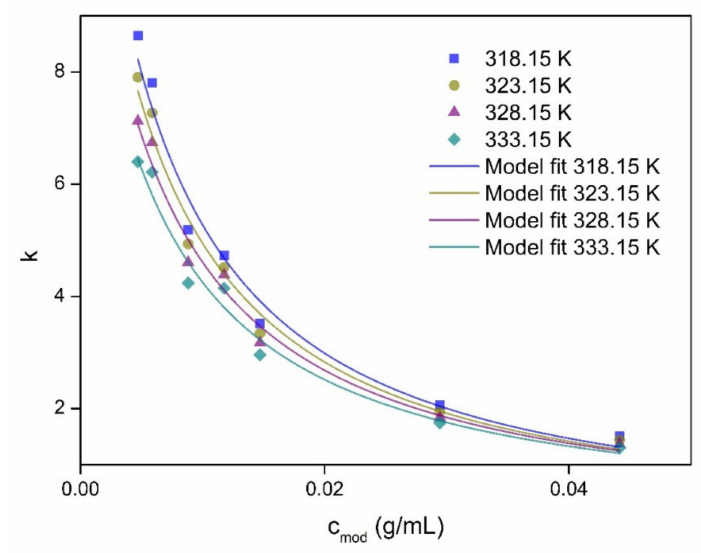
Figure 7. Retention factors of ketoprofen on SIL-Aerogel at different temperatures and model fittings according to MRM-Lan-kcKM. SFC conditions: 191 bar for 318.15 K, 217 bar for 323.15 K, 242 bar for 328.15 K, and 268 bar for 333.15 K, flow rate 2 mL min − 1 , modifier (methanol) fraction at 0.8–7.5 vol.%.